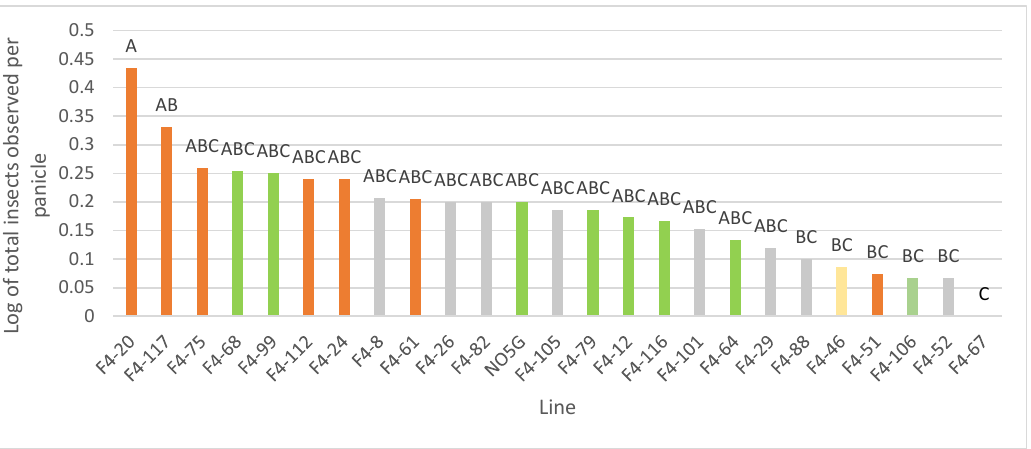
Figure 2. Insects (log10) observed per panicle for the N109A × PI 257,599 F 4 sorghum lines in Tifton, GA 2021. NO5G is PI 257,599 (the common name is No. 5 Gambela). Means with the same letter are not different at α = 0.05. Orange, grey, green, and gold shaded lines were phenotyped on 14 Sep- tember 2021, 21 September 2021, 25 September 2021, and 4 October 2021, respectively. Line F 4 -67 was phenotyped on 4 October 2021.